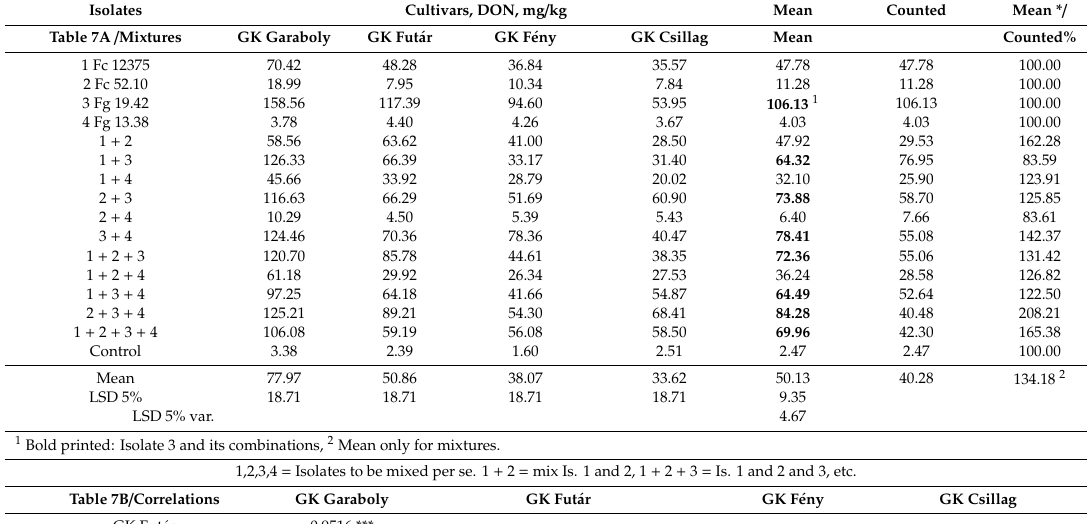
Table 7B / Correlations